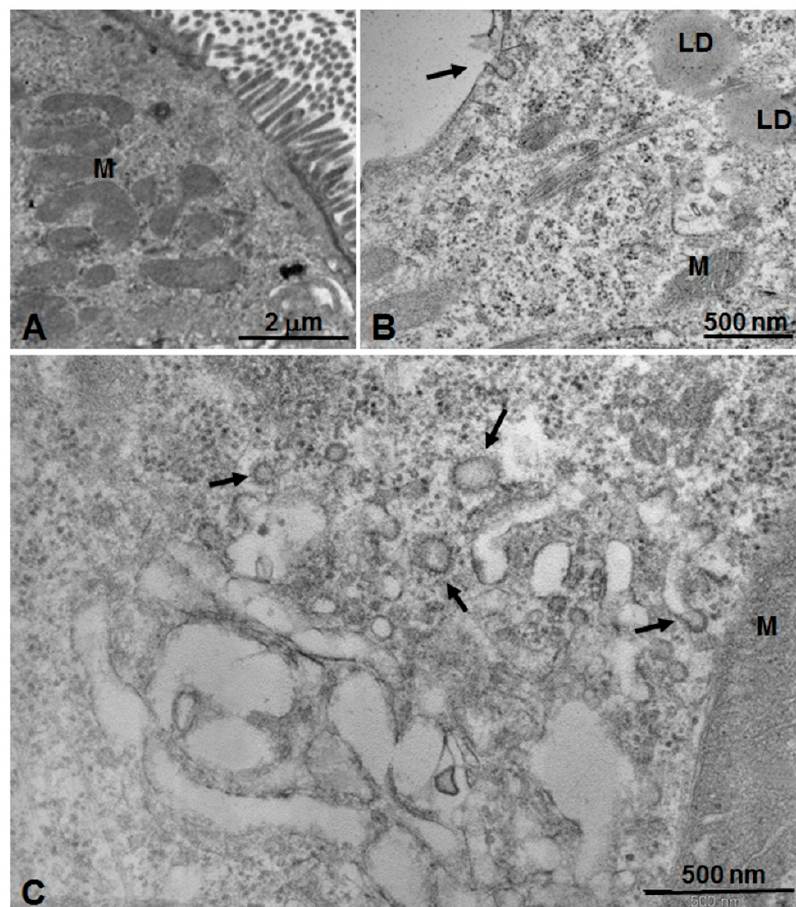
Figure 7. Electron micrographs (TEM) of Caco-2 cell grown in 2D culture in vitro stained with uranyl acetate and lead citrate, analyzed by a transmission electron microscope. ( A ) An untreated Caco-2 cell control with numerous microvilli on the apical surface (upper right) and mitochondria (M) inside the cytoplasm. Scale bar: 2 µm. ( B ) Superficial part of a cell with an evident caveola constituted by invagination of the plasma membrane-coated pits on its inner side (black arrow). In the cytoplasm are visible many free polyribosomes, bundles of cytoskeletal elements, some mitochondria (M), and lipid droplets (LD). Scale bar: 500 nm. ( C ) Cell treated with unloaded PECA-NPs. Numerous coated vesicles distributed in the peripheral part of the cytoplasm are present and associated with cytoplasmic membrane systems (arrows). Scale bar: 500 nm.